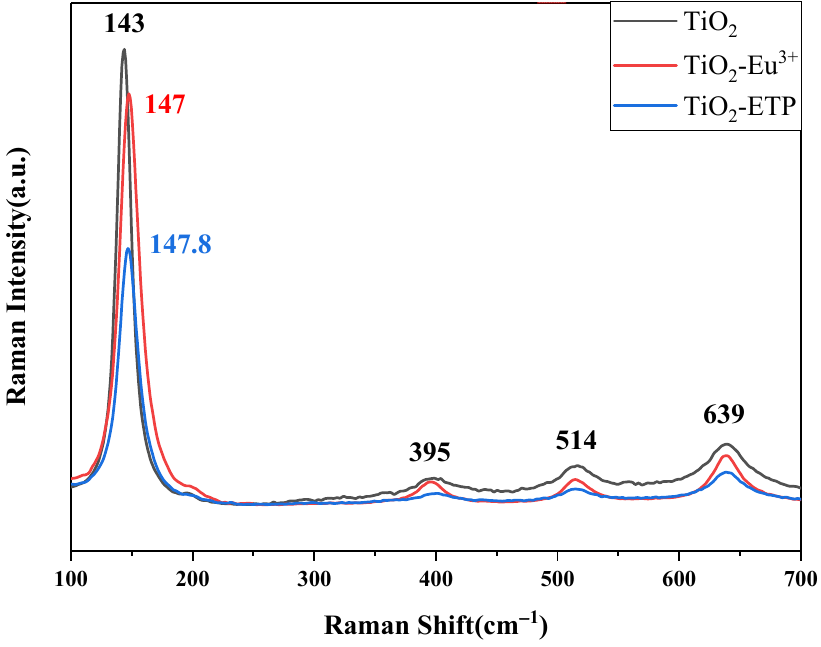
Figure 5. Raman spectra of TiO 2 , TiO 2 ‐ Eu 3+ , and TiO 2 ‐ ETP.